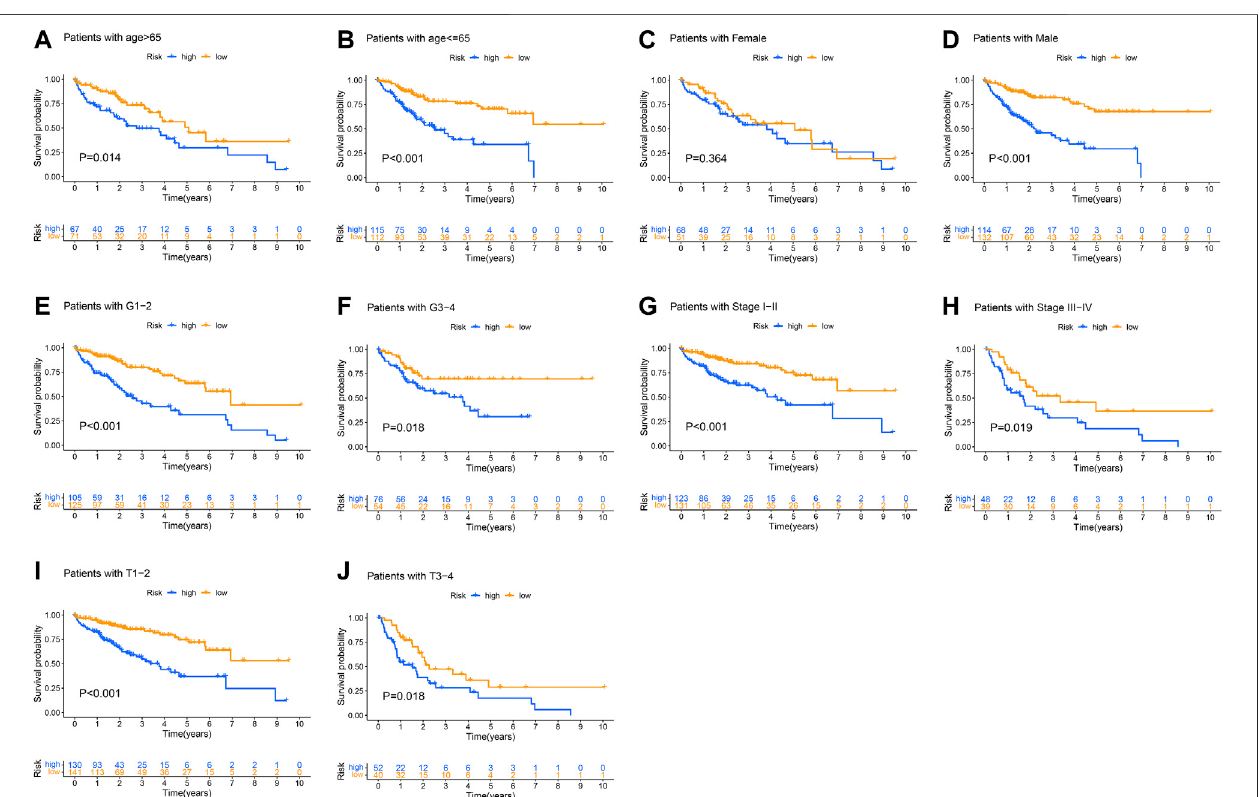
Frontiers in Genetics |